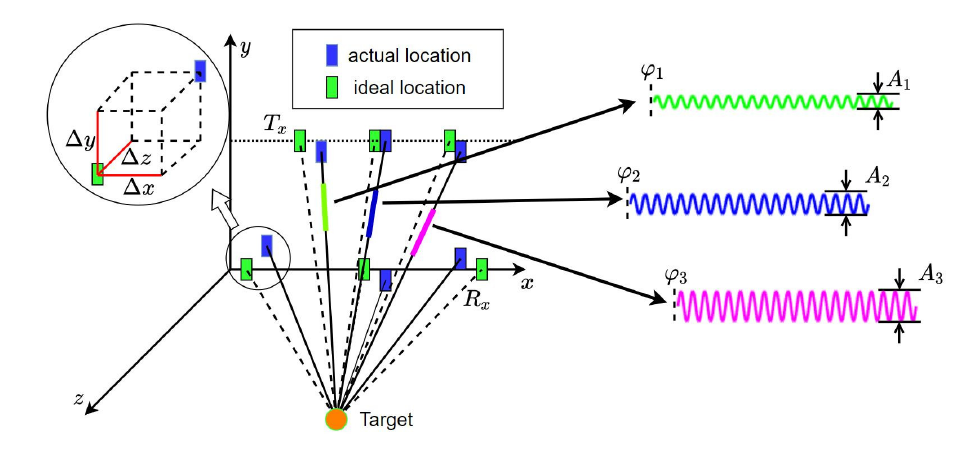
Figure 6. The illustration of three types of errors: magnitude error, initial phase error, and position